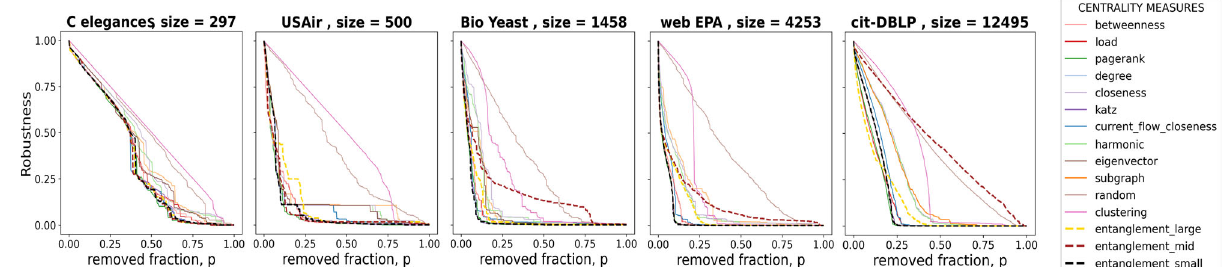
Fig. 5 Robustness analysis of empirical networks. The robustness of biological, social, and transportation empirical networks against random failures and targeted attacks is represented. More speci fi cally, the analyzed networks include the neural network of the nematode worm C. elegans , the US airports, the protein – protein interactions of yeast, the Internet pages of Environmental Protection Agency and the citation network corresponding to the Digital Bibliography & Library Project. Static attacks based on entanglement at small, middle (mid), and large scale are shown as dashed lines and compared against other centrality measures. Similar to the synthetic networks, here, entanglement at large temporal scales is effective in driving the network to its critical point. Interestingly, in some cases, small-scale entanglement is faster in causing the total dismantling, yet it performs as well as or worse than large scale in reaching the critical